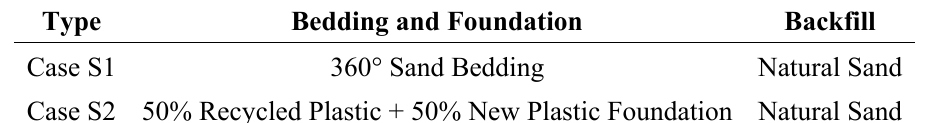
Table 6. Testing cases for small scale lab test.